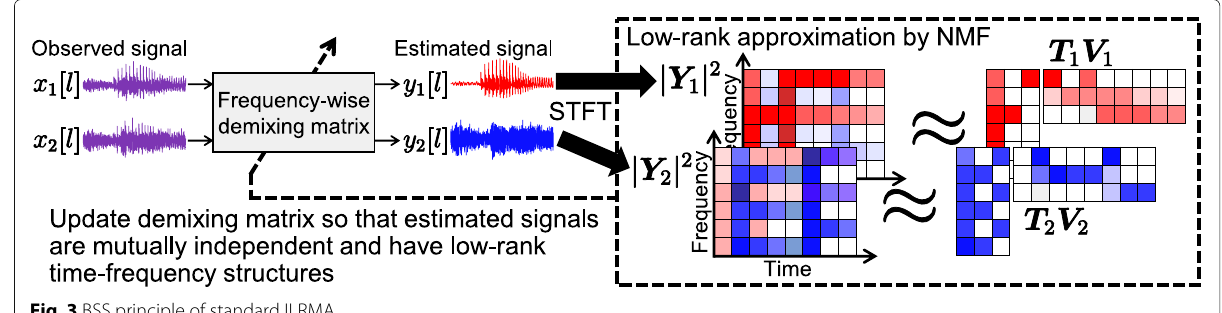
Fig. 3 BSS principle of standard ILRMA